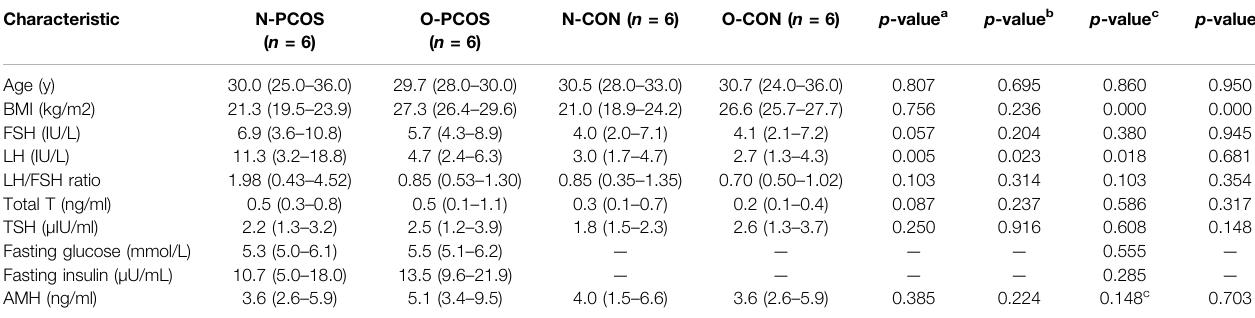
TABLE 1 | Characteristics of control women and patients with PCOS.